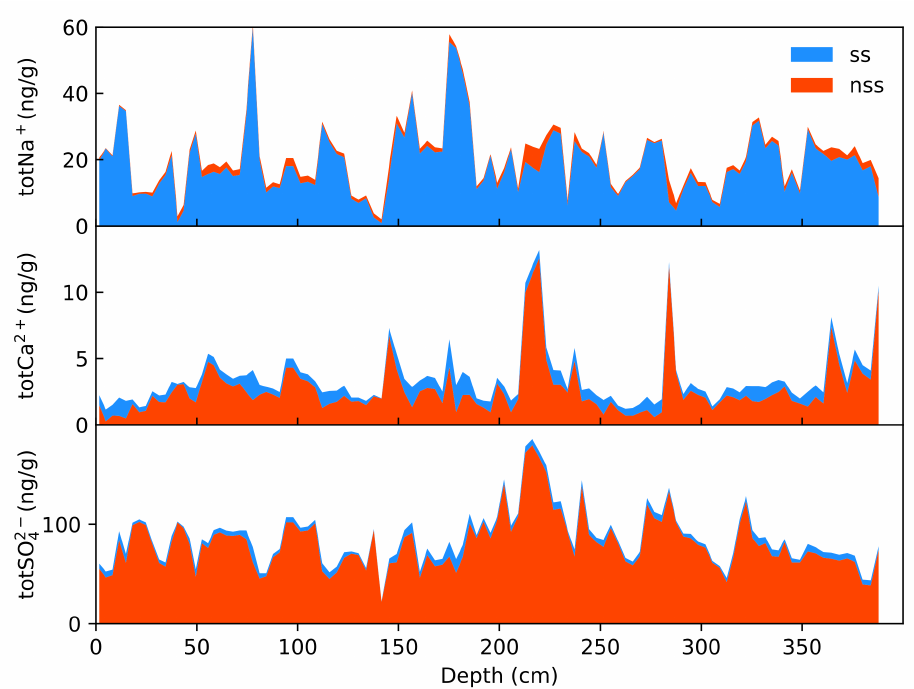
Figure 2. Sodium ( top ), calcium ( middle ) and sulphate ( bottom ) concentration vs. depth profiles. The total measured sodium, calcium and sulphate are shown as the sum of the two different contri- butions: sea salt (in light blue), and non-sea salt (in